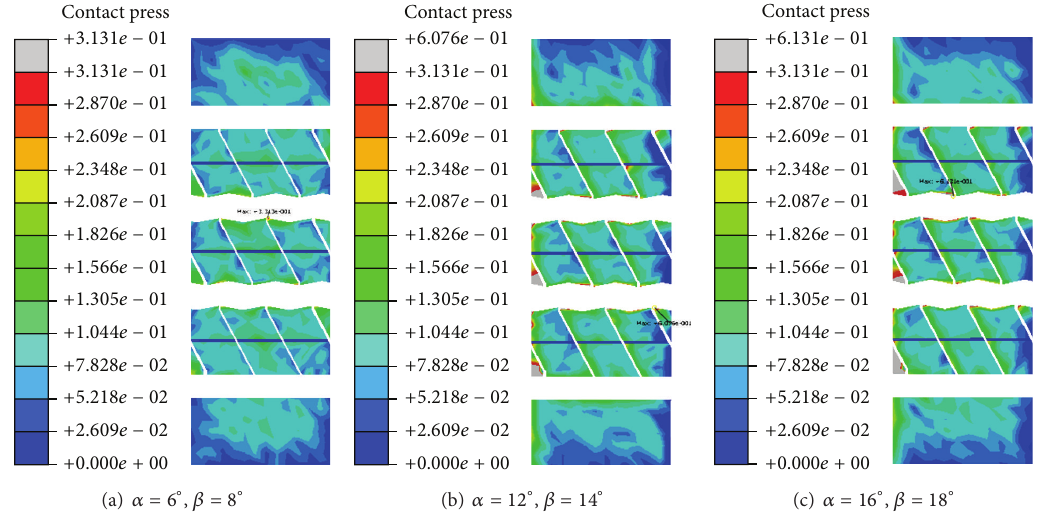
Figure 12: Contact press of the tread block under different slope angles.